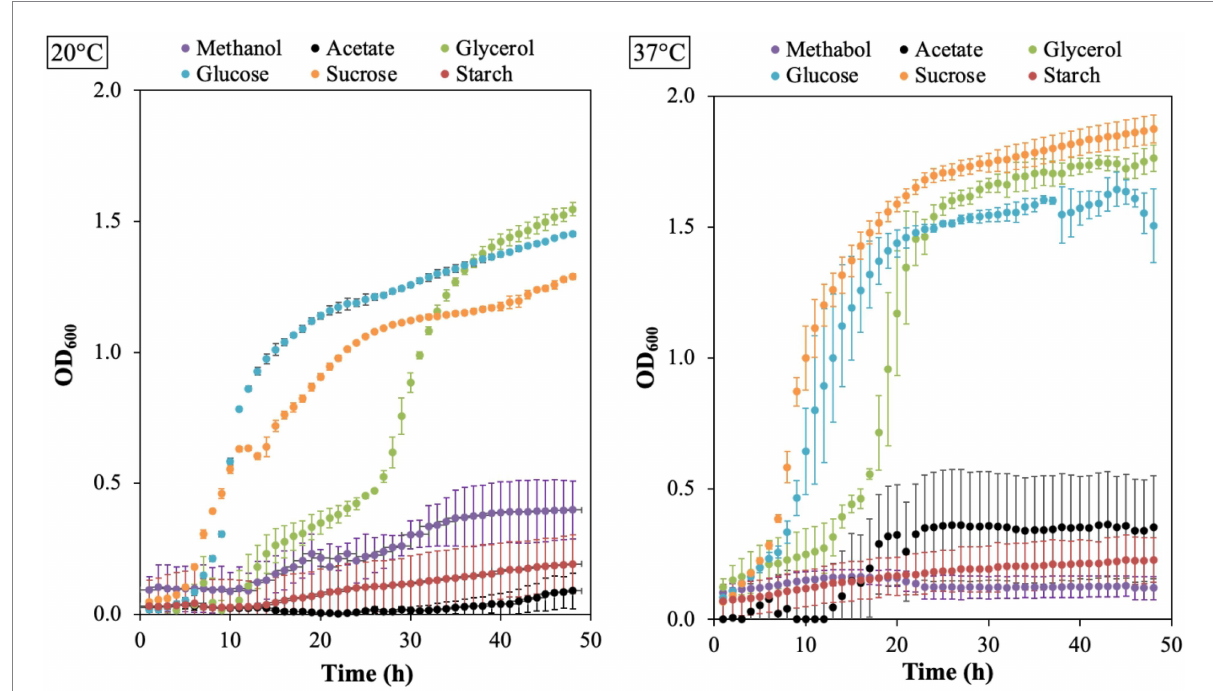
FIGURE 5 The growth plots for B. aryabhattai LAD. LAD cells were cultivated in the optimum growth medium with different carbon sources, i.e., methanol (0.5, v v − 1 ), sodium acetate (2%), glycerol (2%), glucose (2%), sucrose (2%), and starch (2%), respectively. The temperature for LAD growth included 20 ° C and 37 ° C. Each data point represents the mean value of three replicates.